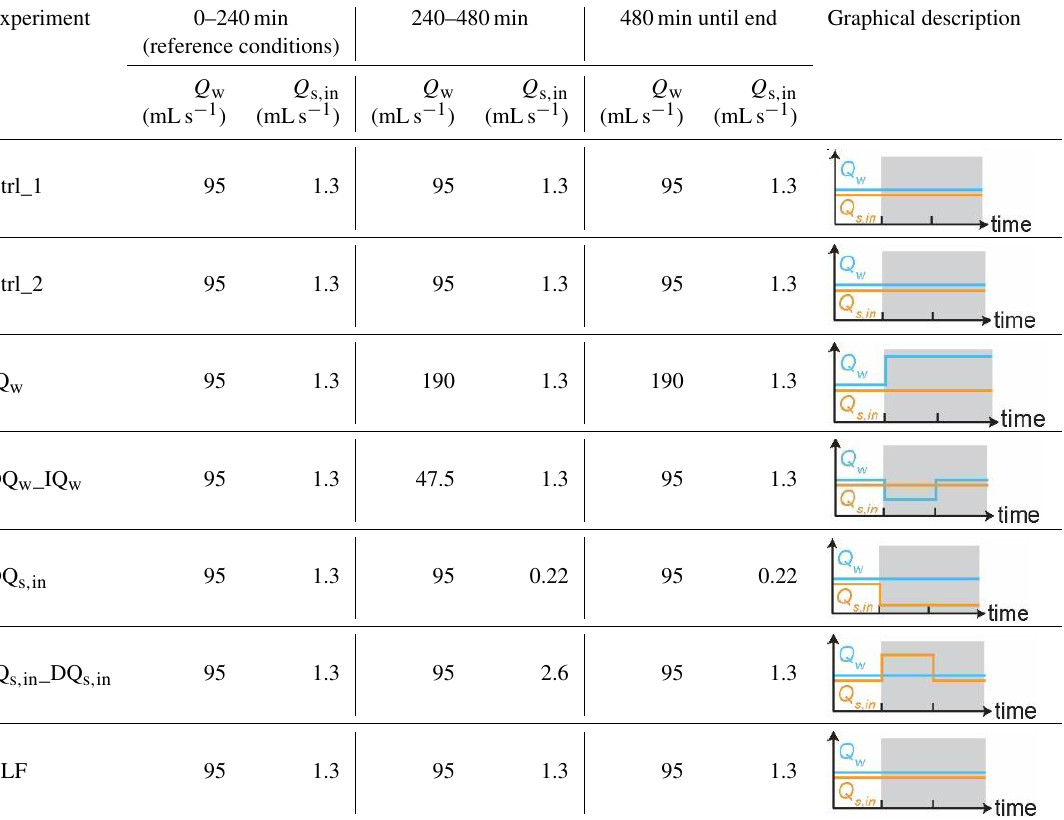
Table 1. Water and sediment inputs to the experiments.